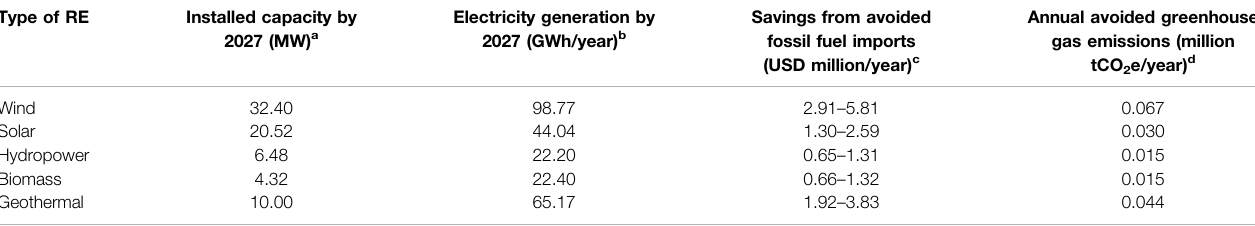
TABLE 1 | Reconstructed data (estimated) for major forms of renewables for 2027 identifying energy installation, generation, avoided fuel imports and greenhouse gas emissions. Type of RE